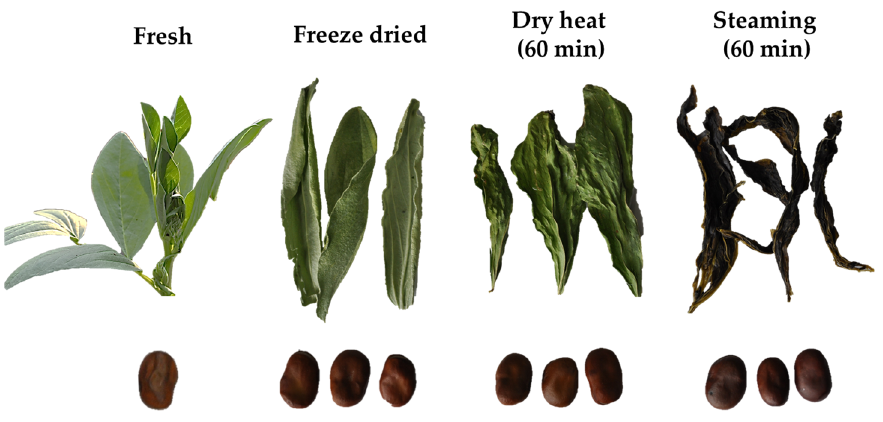
Figure 1. Morphological changes in faba leaves and seeds before and after heat treatment.